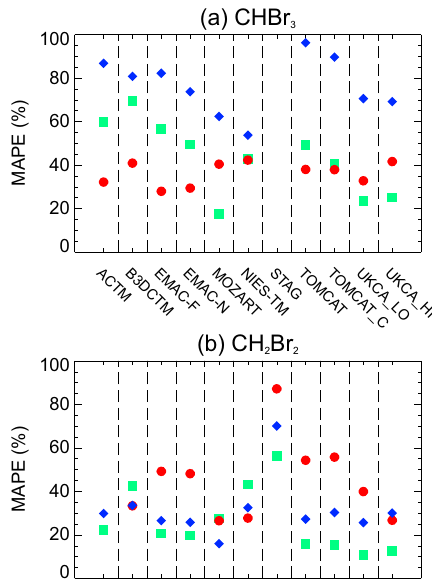
Figure 7. Overall mean absolute percentage error (MAPE) between model (a) CHBr 3 and (b) CH 2 Br 2 tracers and corresponding sur- face observations, within the tropics only (i.e. sites KUM, MLO, TAW, SMO and the TransBrom and SHIVA ship cruises). Note, the scale is capped at 100%. A small number of data points fall out- side of this range. Green squares denote the CHBr 3 _L tracer, blue diamonds denote the CHBr 3 _O tracer and red circles denote the CHBr 3 _Z